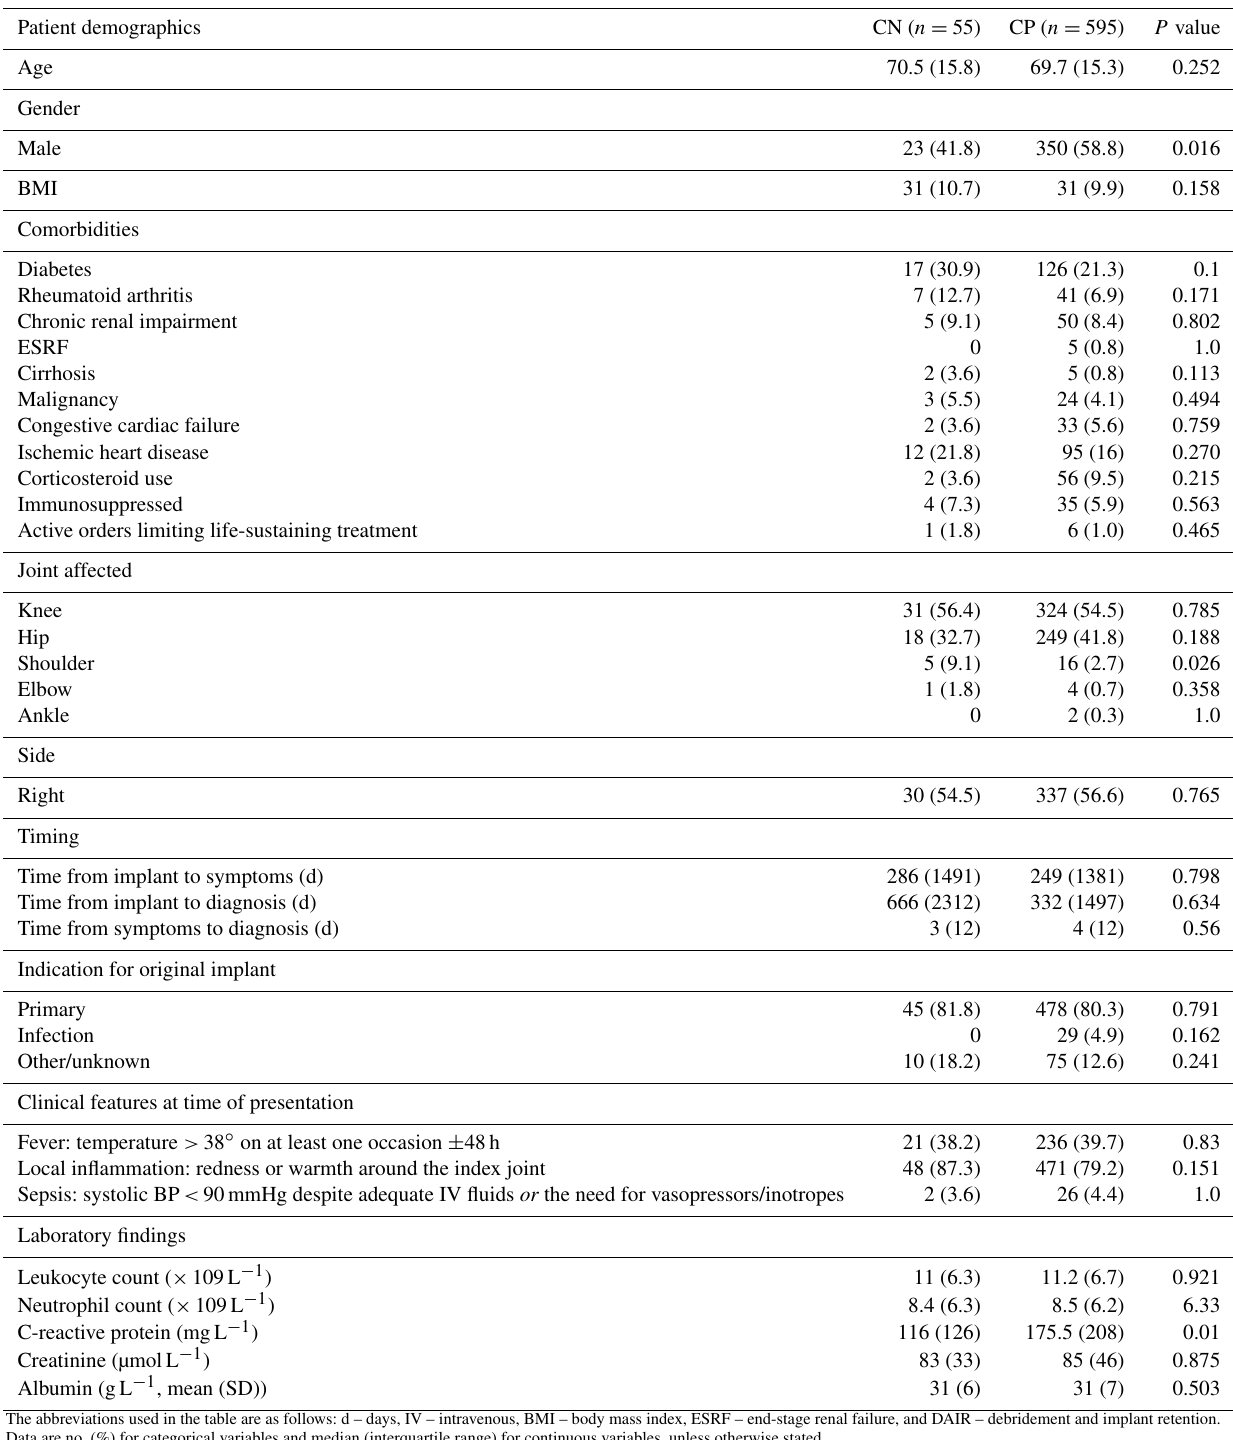
Table 1. Baseline characteristics of CN patients compared with CP